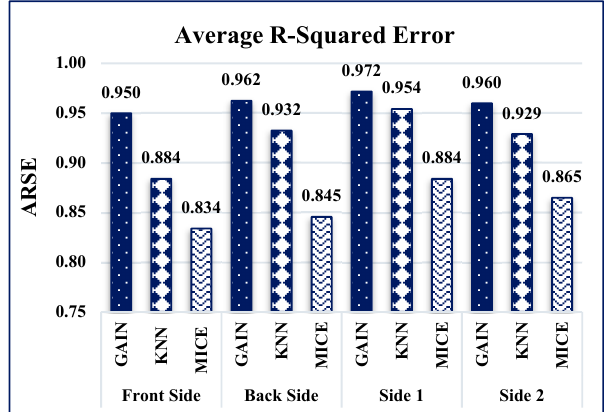
Figure 15. ARSE comparison. Sensors 2021 , 21 , x FOR PEER REVIEW